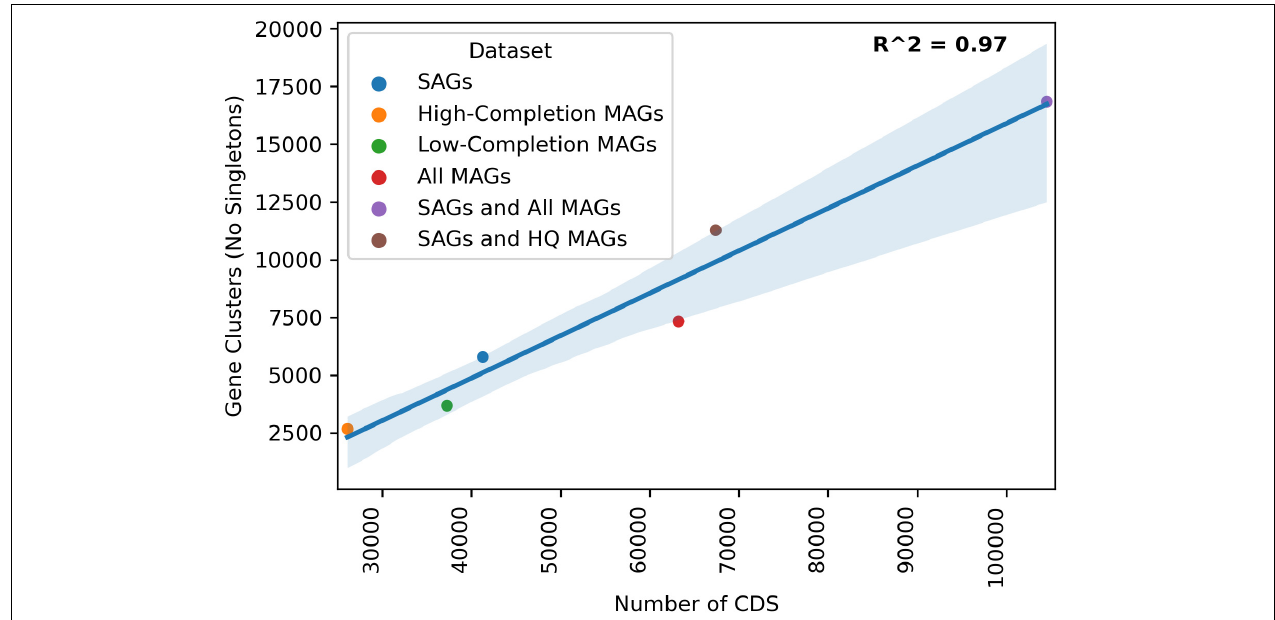
FIGURE 4 | Linear regression of total Number of CDS in a given dataset to the amount of gene clusters produced by the Anvio Pangenomics workflow. HIGH-COMPLETION MAGs are the 10 high-completion MAGs discussed in Seyler et al. (2020). LOW-COMPLETION MAGs are the low-completion MAGs not discussed in Seyler et al. (2020) but produced from that same sampling, All MAGs are those the HIGH-COMPLETION and LOW-COMPLETION MAGs combined. The SAGs from this study were clustered alone (blue) and then added to the HIGH-COMPLETION MAGs (brown) or all of the MAGs